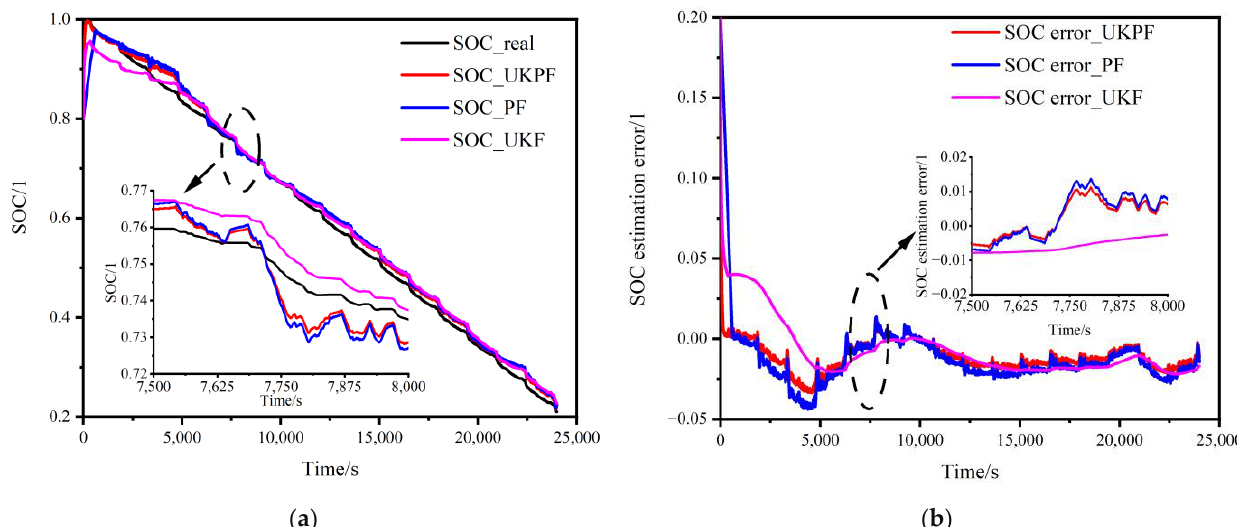
13 of 17 Figure 9. RC loop identification result: ( a ) R 1 , C 1 ; ( b ) R 2 , C 2 . 4.3. Multi-Time Scale Joint Estimation Results (1) UKPF algorithm estimation of SOC To verify the validity and accuracy of the UKPF-based charge state estimation, the results of the UKPF-based charge state estimation were compared with those of the other two algorithms based on the PF and UKF algorithms. The experimental data measured in the UDDS conditions were used for a simulation in MATLAB. Figure 10 shows the SOC_discharge estimation results based on the three algorithms when the SOC value r anges from 1 to 0.2. When estimating a battery’s SOC_discharge, the estimated results of the three algorithms can be adequately used to trace the changes of the real value, as shown in Figure 10a. Compared with the SOC_discharge’s estimated results of the UKF and PF, the estimated results of the UKPF are much more realistically close to the real value. The SOC_discharge estimation errors of the UKF and PF fluctuate greatly, and the stability is weaker than that of the UKPF algorithm, as shown in Figure 10b. Combining the UKF with the PF, the UKPF algorithm proposed in this paper can ensure the diversity of particles, and improve the estimation accuracy and stability of the PF algorithm, which can effectively solve the particle deg- radation problem of the PF algorithm in reference [1]. Furthermore, the UKPF algorithm can overcome the problem of accurately reducing the calculation accuracy due to the uncertainty of system noise in the use of the UKF algorithm in reference [2], which helps